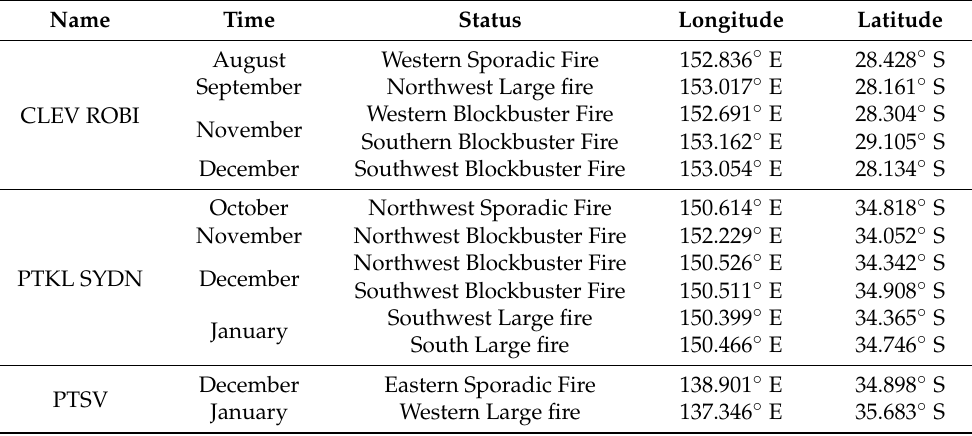
Table 2. Forest fire information statistics near GNSS